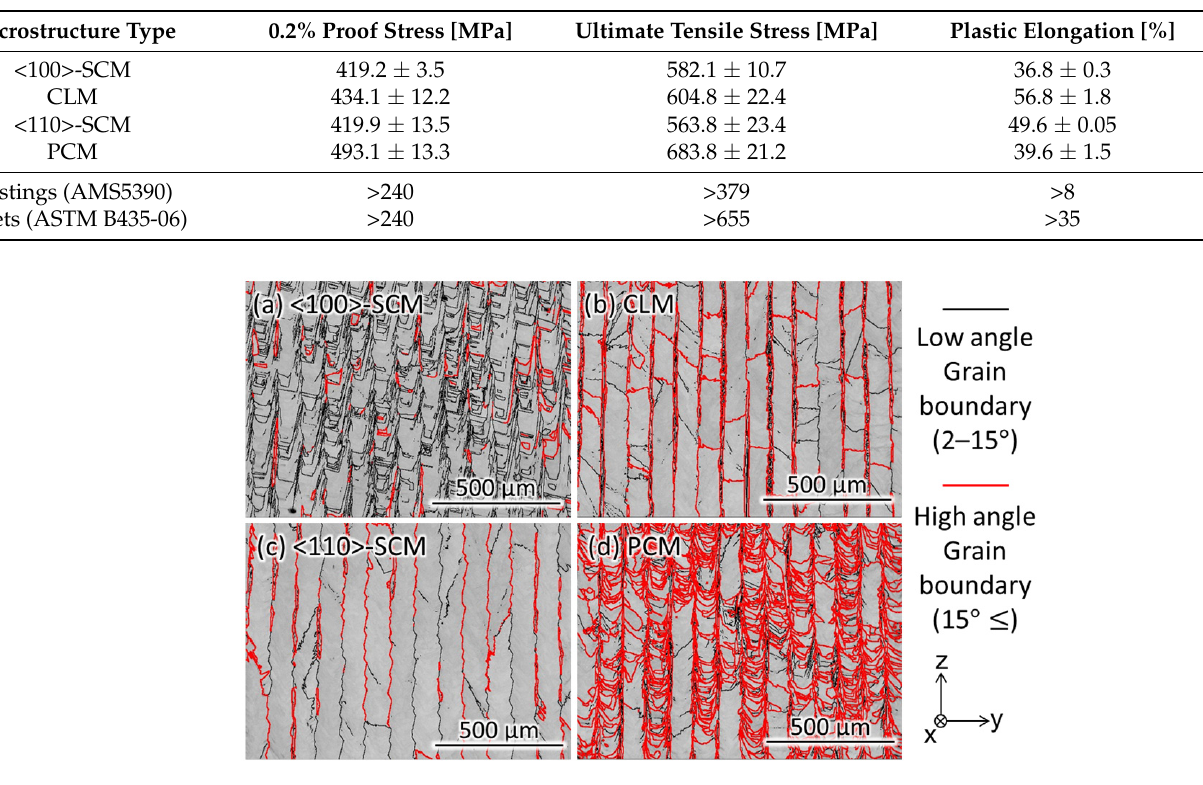
Figure 6. Grain boundary maps obtained by EBSD measurements of the four typical crystallo- graphic textures. Table 2. Tensile properties of the four typical crystallographic textures and the requirement values in Hastelloy-X castings (AMS5390) and Hastelloy-X sheets (ASTM B435-06). Microstructure Type